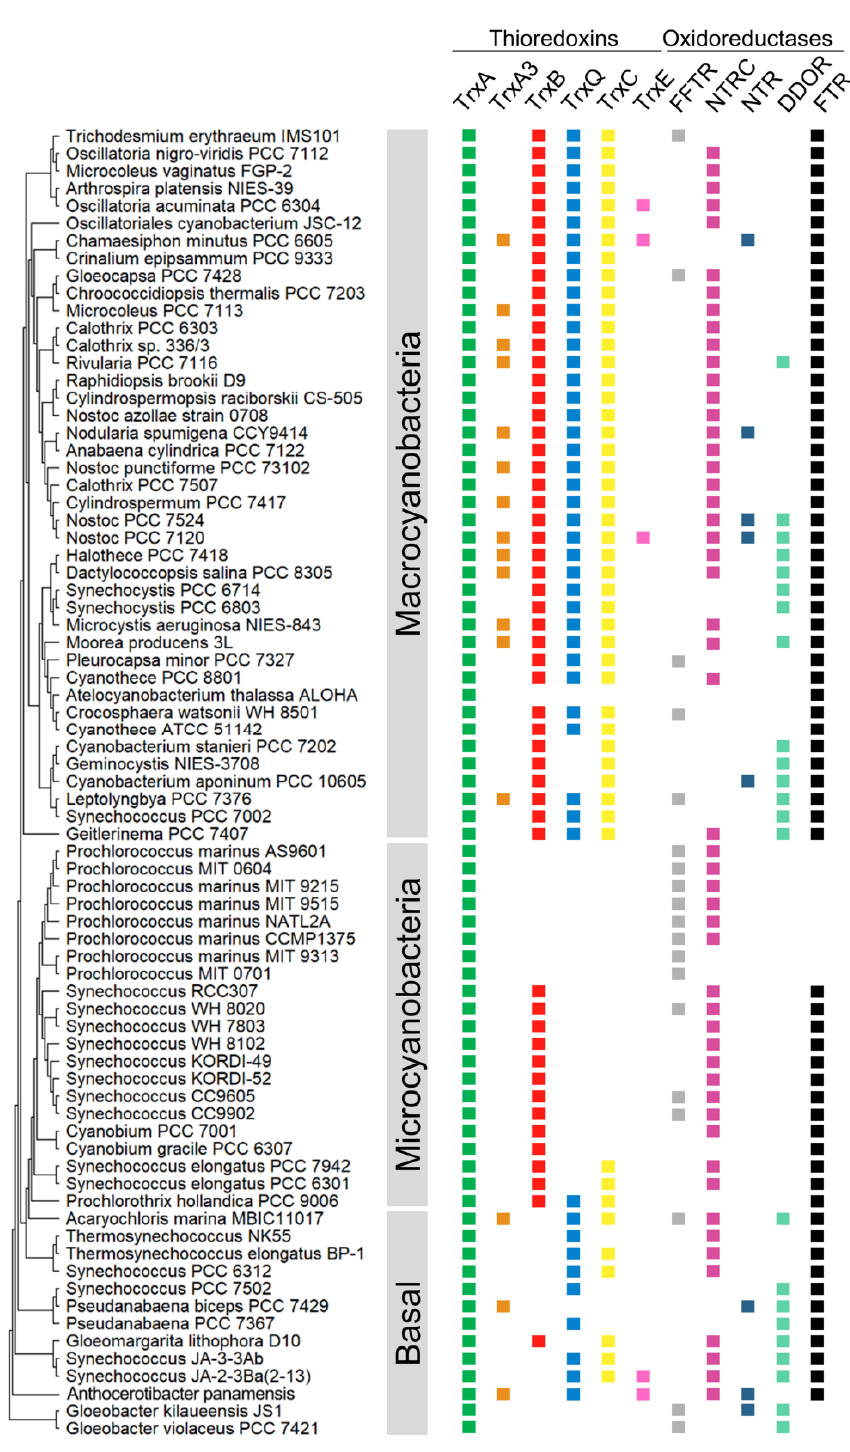
Figure 5. Distribution of Trx systems and related enzymes across the phylum Cyanobacteria. The phylogenetic tree was estimated from 16S rRNA using the maximum likelihood method implemented in MEGA 11.